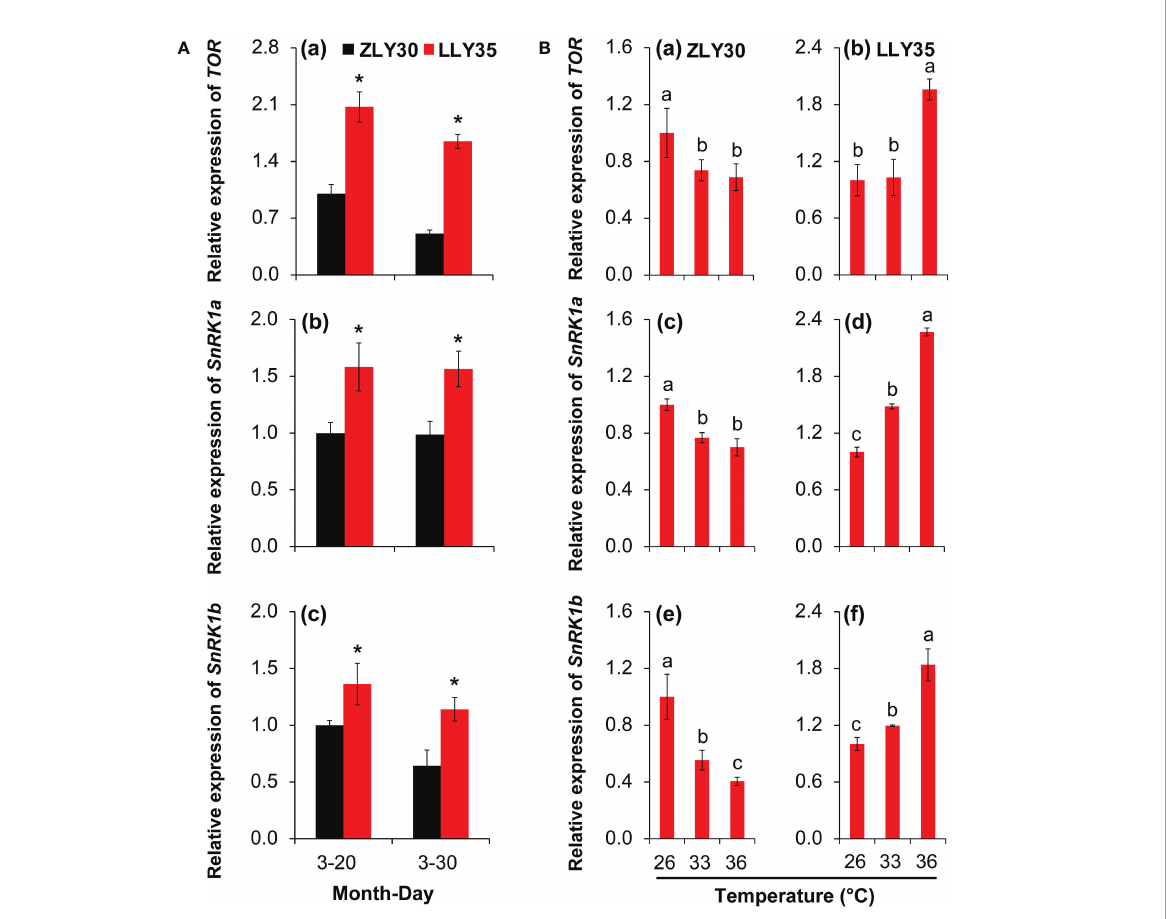
FIGURE 6 Effect of different sowing times and temperatures on energy allocations in grains of rice. (A) , Relative expression of TOR (a) , SnRK1a (b) , and SnRK1b (c) in ZLY30 and LLY35 at different sowing times; (B) Relative expression of TOR (a, b) , SnRK1a (c, d) , and SnRK1b (e, f) of two cultivars under different temperatures; Vertical bars denote standard deviations ( n =3). “ * ” indicated signi fi cant difference while “ No.s ” indicate no signi fi cant difference at the 0.05 probability level between the ZLY30 and LLY35 within one sowing time using T-test analysis. Different letters indicate signi fi cant differences with a least signi fi cant difference test at P ≤ 0.05 among different temperatures within one genotype using one- way analysis of